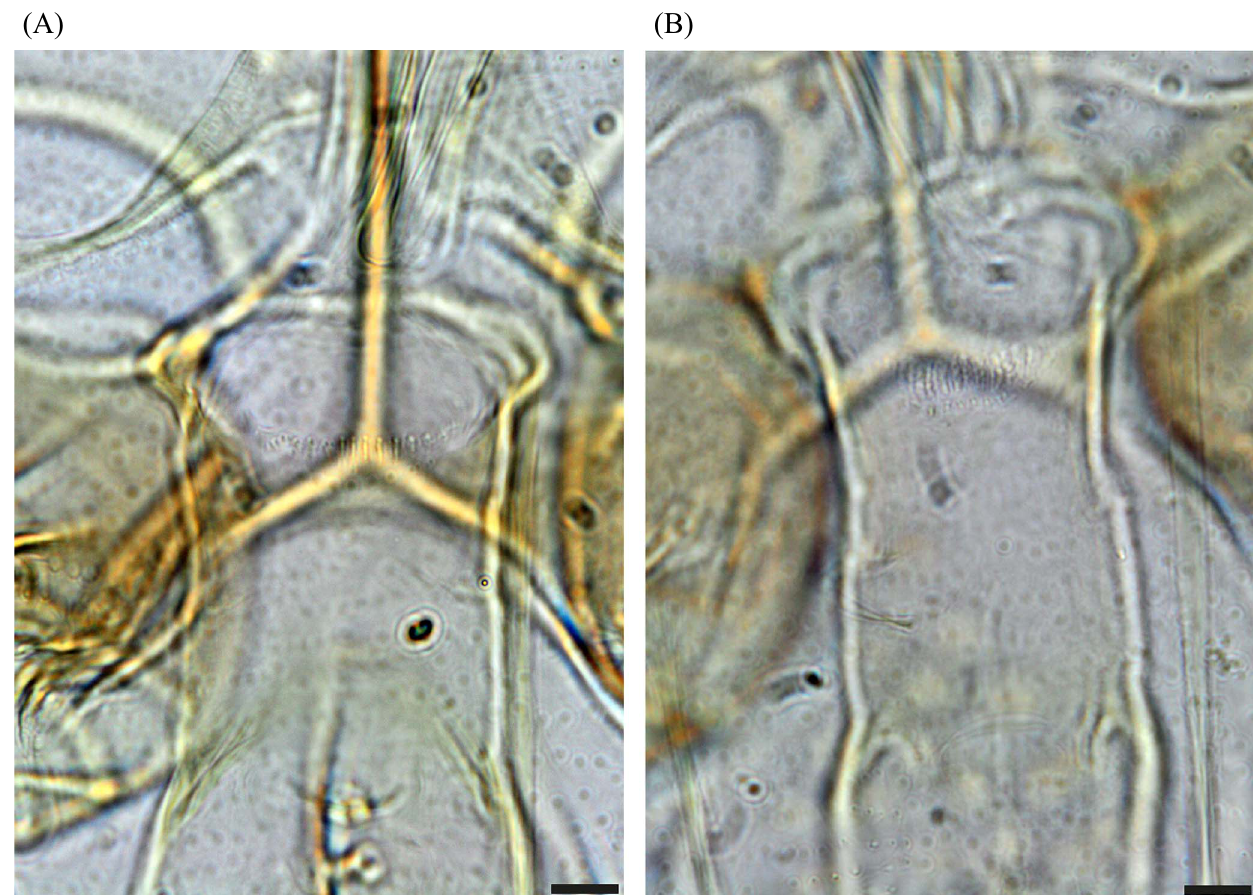
Figure 16. Cibarial armature of males of Sergentomyia sclerosiphon (A) and Se. anka (B). Bars = 10 l